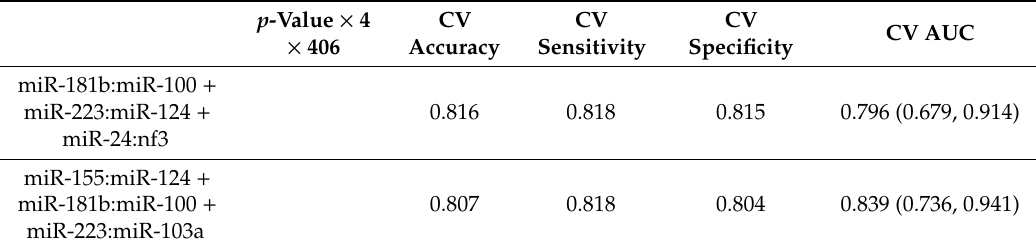
Table 3. Comparison of ALL vs.